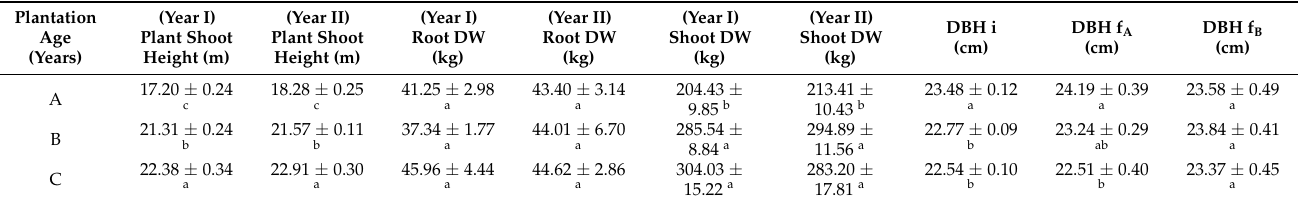
Table 1. Shoot and root growth parameters in each one of the three pine stands were measured in two different